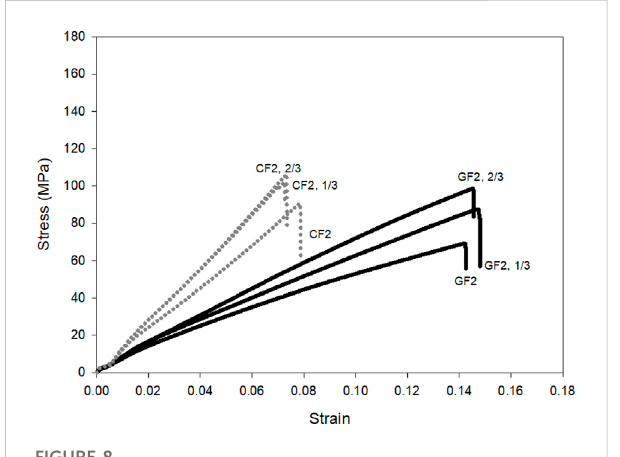
FIGURE 10 Specimen displacement according to the position of 4-layer reinforcement.